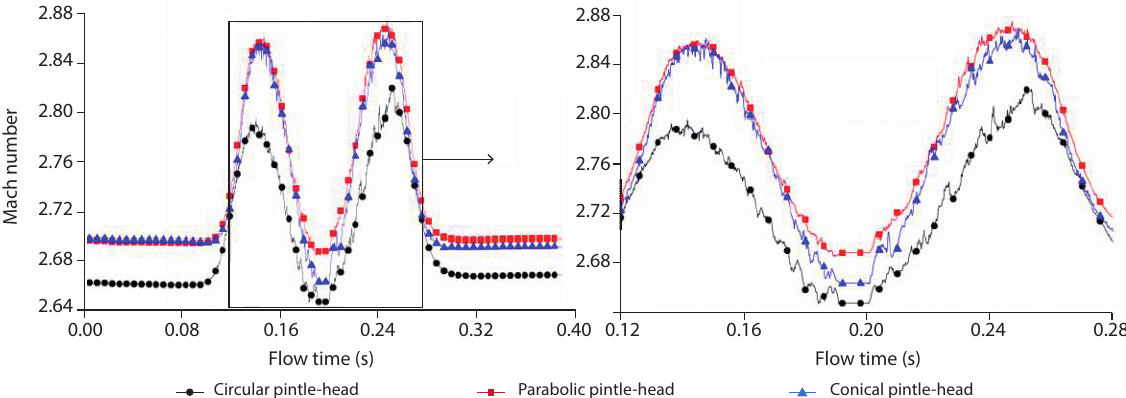
Figure 9. (a) Mach number simulation data of three different models at the outlet of nozzle; (b) Magnified display from the flow time of 0.12–0.28s